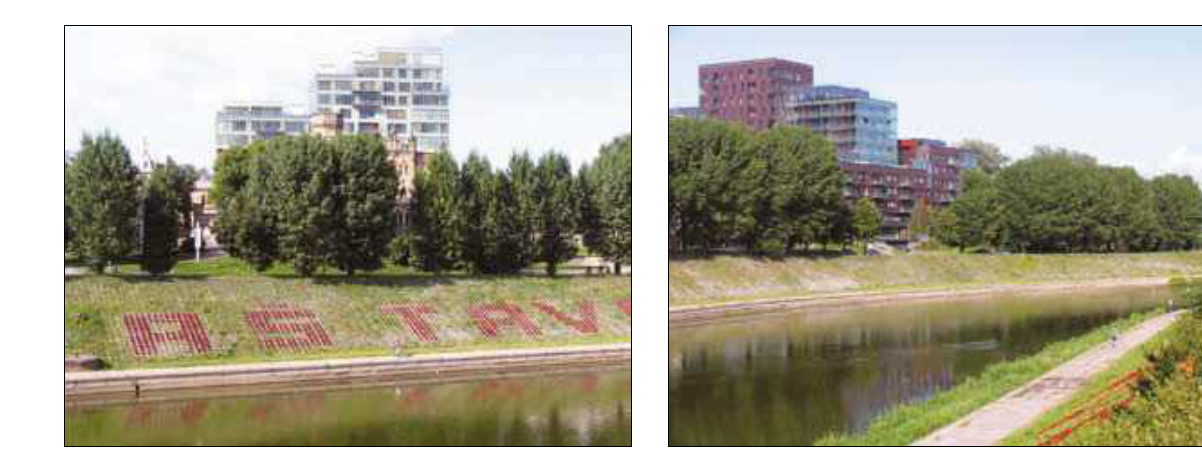
16 pav. komercinių patalpų ir dau­giabu­čių gyvenamųjų namų kompleksas a­. Ju­ozapavičiau­s g. (archit. Fig. 16. complex of the commercial premises and blocks of flats in a­. Ju­ozapavičiu­s st. a­rch. D. Pau­liu­konienė, a­. Pliu­čas, M. Nagelė, e.